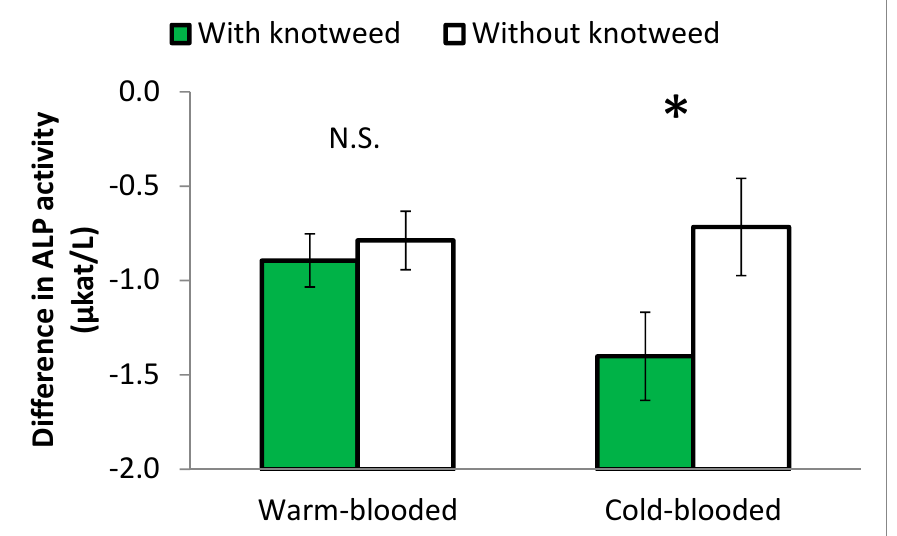
Figure 5. Differences in equine ALP activity between the beginning and the end of Experiment 1 among horses fed and not fed knotweed. The warm-blooded and cold-blooded breeds were compared. Statistically different values at p ≤ 0.05 are marked with *. N.S. = non-significant difference. This effect was significant in Experiment 1 but not in Experiment 2, in which a number of ALP values were